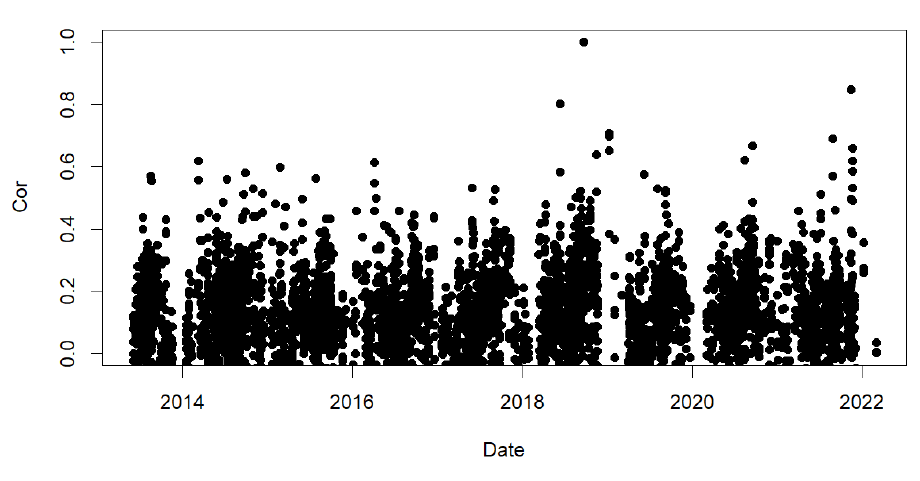
Figure 6. Daily evolution of the correlated parameter estimated for all the different radar parameters (Cap, Max, Top, Vil, and Rn1) and lightning data for the period 2013–2021.